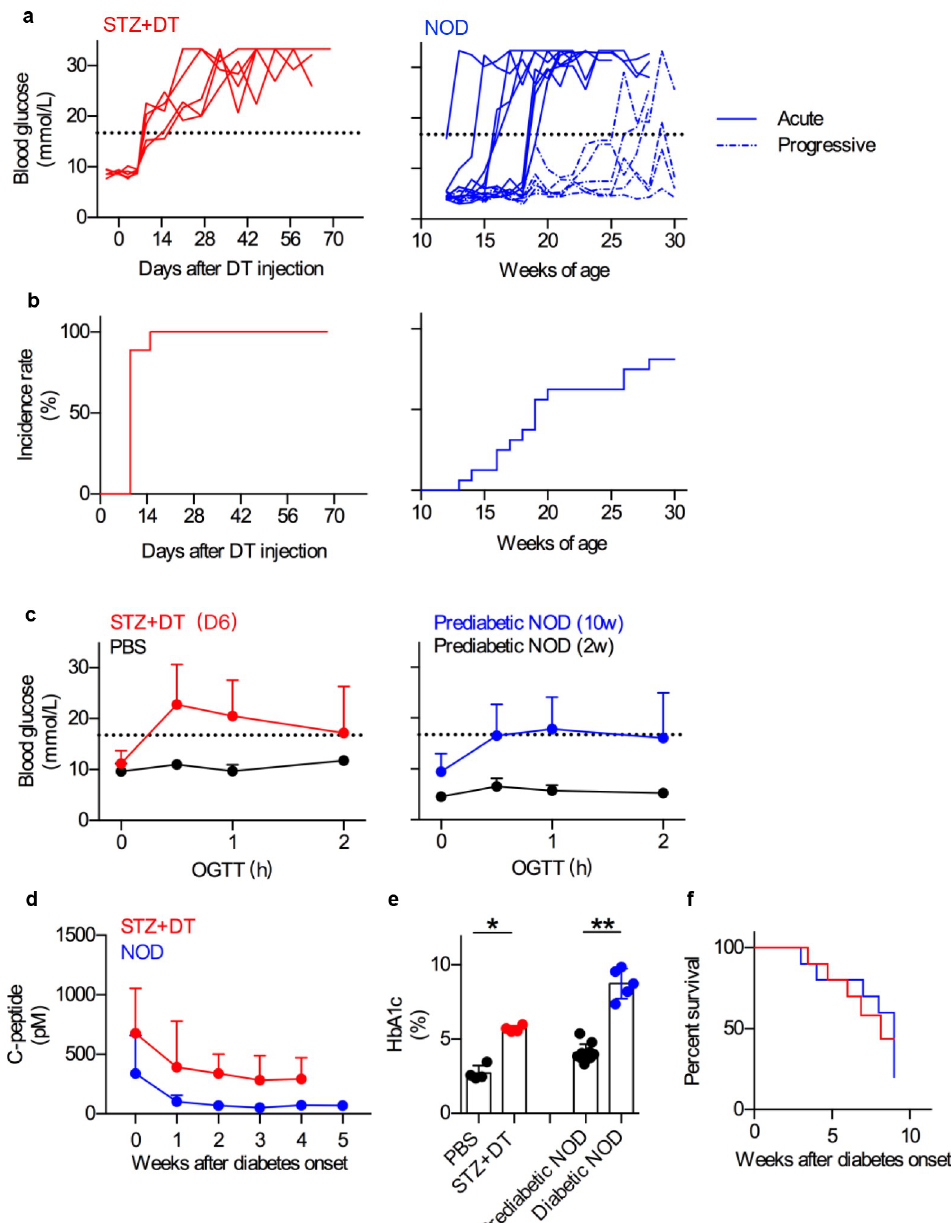
Fig 2. Diabetes symptoms covered by both STZ+DT and NOD model. a . Blood glucose fluctuations of STZ+DT mice (left, red, n = 5) and NOD mice (right, blue, n = 15). Blood glucose over 16.7 mmol/L was identified as hyperglycemia (Black dash line). Acute diabetic NOD mice (Blue lines) and progressive ones (Blue dash lines) were categorized. b . Diabetes incidence rate of STZ+DT mice (left, n = 9) and NOD mice (right, n = 16). c . abnormal OGTT of prediabetic STZ+DT mice at day 6 (left) and prediabetic NOD mice at 2-week or 10-week of age (right). Statistics comparing to PBS control or pre-diabetic mice were shown. n = 5. N = 3. d . Serum C-peptide loss after diabetes onset. Statistics comparing to week 0 were shown. n = 5. N = 3. e . Hemoglobin (HbA1c) of STZ+DT mice (8 weeks after diabetes onset) and NOD mice (10-week for pre-diabetic and 17-week for diabetic). n = 5. f . Survival of STZ+DT and NOD mice after diabetes onset. n = 10. � , p < 0.05; �� , p < 0.01.